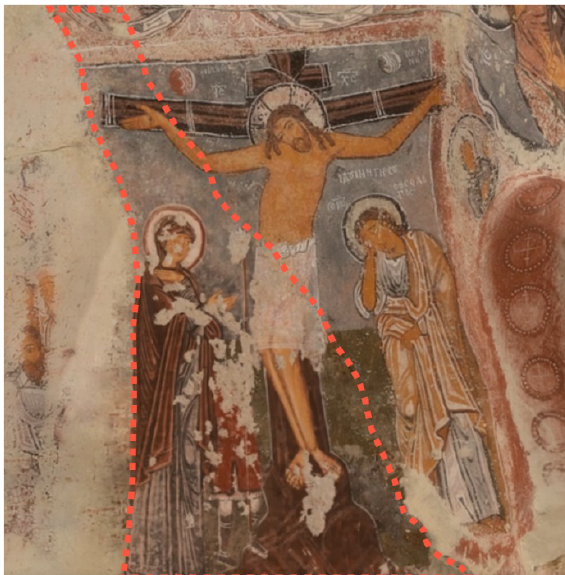
Figure 10. The Crucifixion of Merymana Kilisesi after Virtual Reconstruction (The red dotted line area is the part where virtual reconstruction